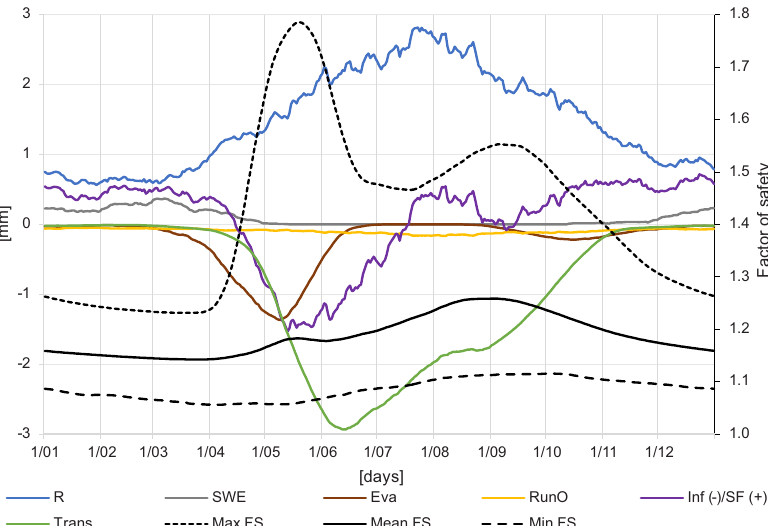
Fig. 11. Conceptual distribution of the FS against the background of annual hydrological balance components. eva – evaporation; fs – factor of safety; inf (−)/sf (+) – infiltration (negative values)/subsurface flow (positive values); Max FS – maximum value of the FS; Mean FS – mean value of the FS; Min FS – minimum value of the FS; R